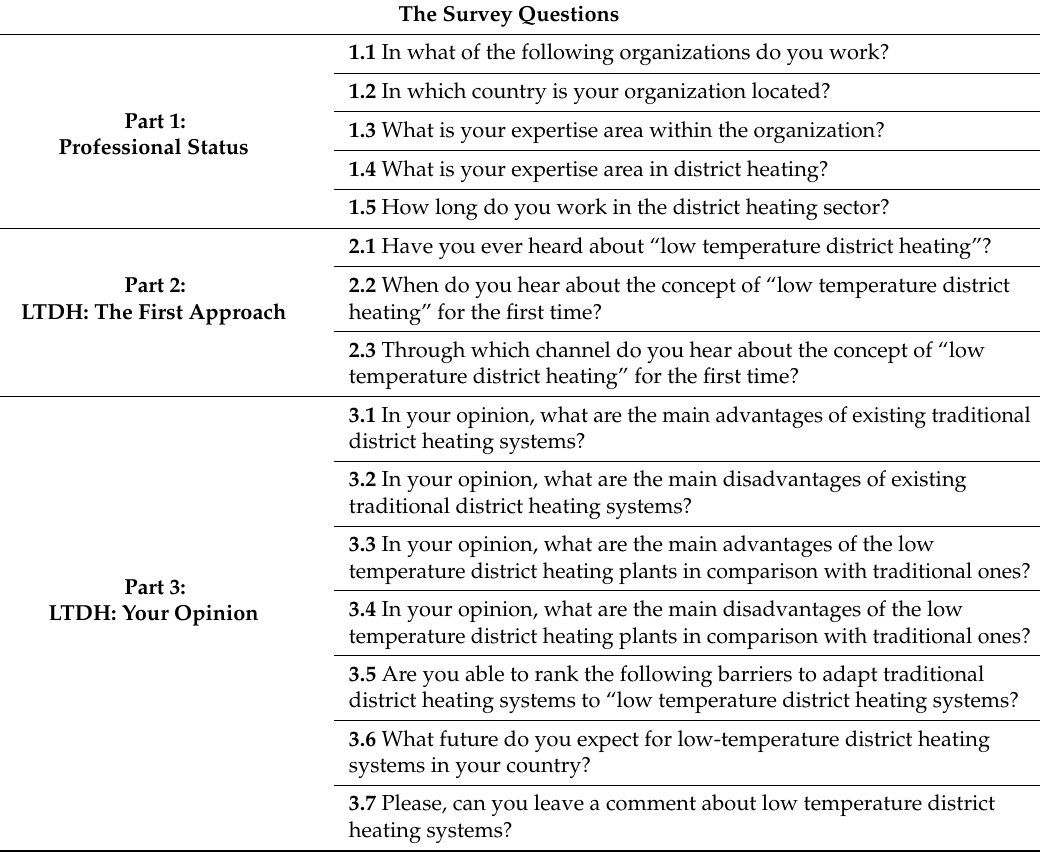
Table A1. The expert opinion survey questions.